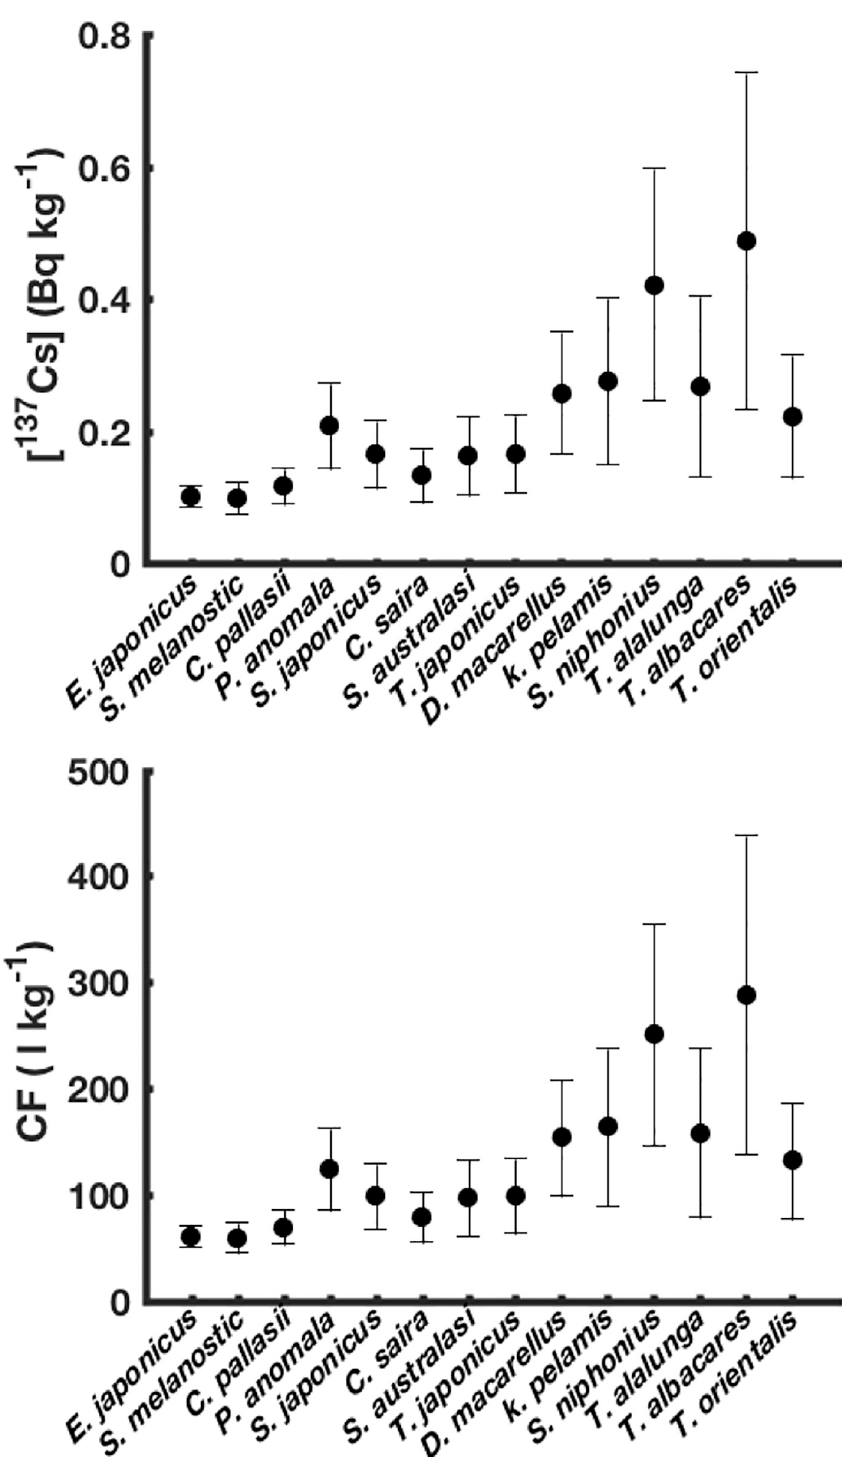
Fig 6. Simulated 137 Cs activity concentrations (Bq kg -1 wet weight) and concentration factors (l kg -1 ) for the 14 studied species in the steady state conditions before the accident. The studied species are shown in an increasing order of their asymptotic maximum